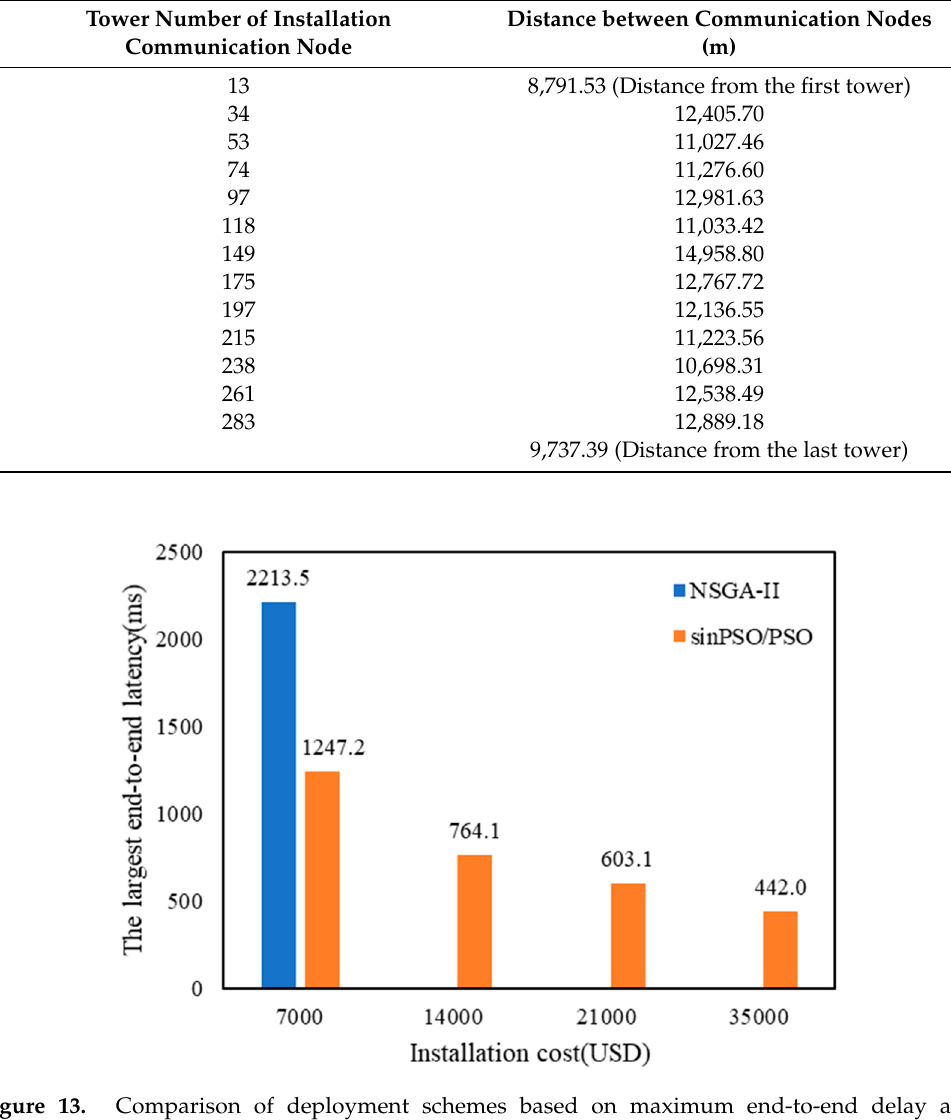
Table 6. The specific layout of Scheme 1 and the distance between communication nodes.